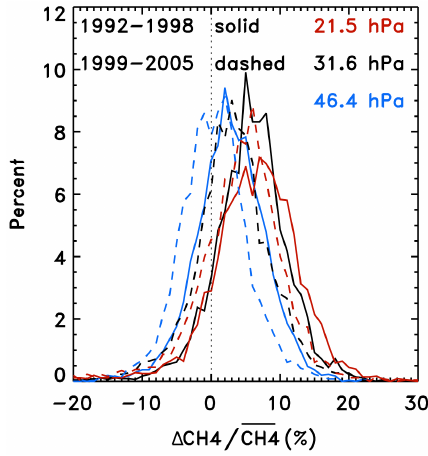
Figure 14. Histograms of percentage differences between HALOE and simulated CH 4 at 46.4hPa (blue), 31.6hPa (black) and 21.4hPa (red) for all HALOE profiles between 35 and 55 ◦ S for 1992– 1998 (solid) and 1999–2005 (dashed).